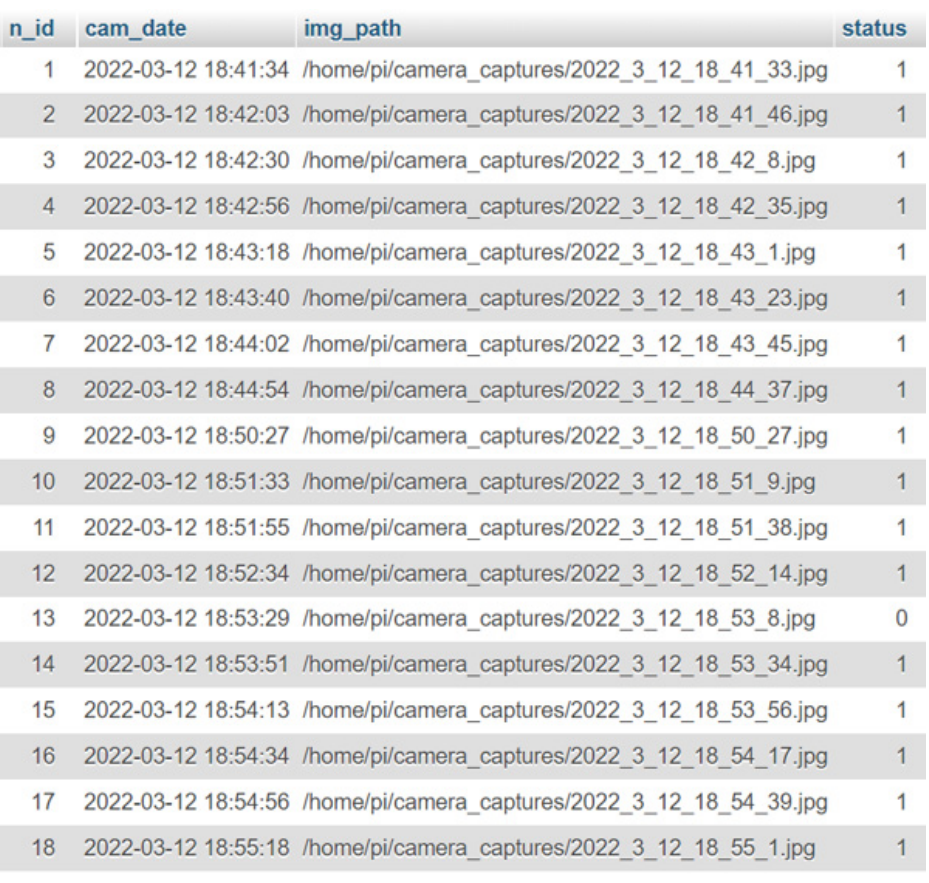
tures to fog computations. The average accuracy of the image capturing based on the trained TensorFlow Lite model approached 99.8% under the online test in a plastic injec- tion factory for a week. Although it did not reach a perfect result, the errors could be eliminated in the following fog and cloud computations. Combining SSIM and classifica- tion processes in the edge device, the frame rate of the system for capturing images reached 45 per second in average. The fog node integrates multiple features from end devices and extracts mid-level features with TensorFlow Lite model. In this study, fog node is a mini-cloud containing several end devices. After receiving data from end de- vices, fog node recognizes digit numbers and transmits the result to the cloud server. Cloud server was responsible for abnormal event detection of temperature change and